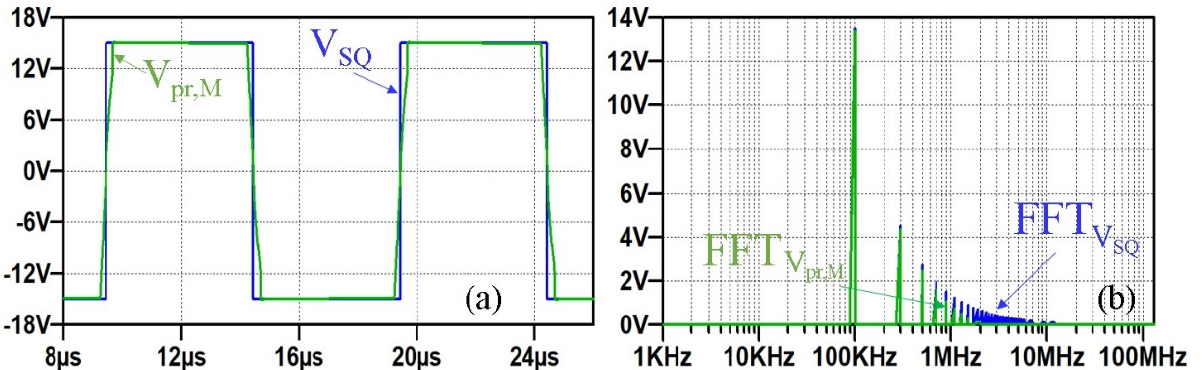
Figure 27. ( a ) square voltage wave (V SQ ) typical of a hard-switching converter compared with the primary voltage (V pr,M ) of the main HF transformer. ( b ) FFT of the voltage wave applied by the proposed converter to the primary side of the main transformer and the FFT of square wave voltage. The proposed auxiliary power supply solution compared to a DC-distributed supply with local converters (one for each load, isolated or not), features a single main DC/AC bridge converter, followed by one transformer and one rectifier bridge for each load (with or without LDO regulator, based on the specific load